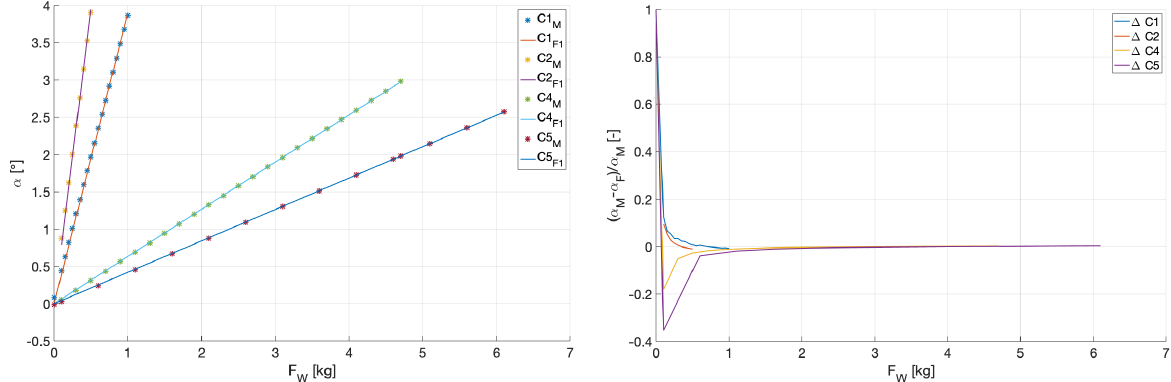
Figure 5. Function SwingF 1: fitting of the points for the analysis cases C1,C2,C4,C5 and difference of the measured value indicated with M to the fitted value F normalised by the measured value—in relation to the calibration weights F W